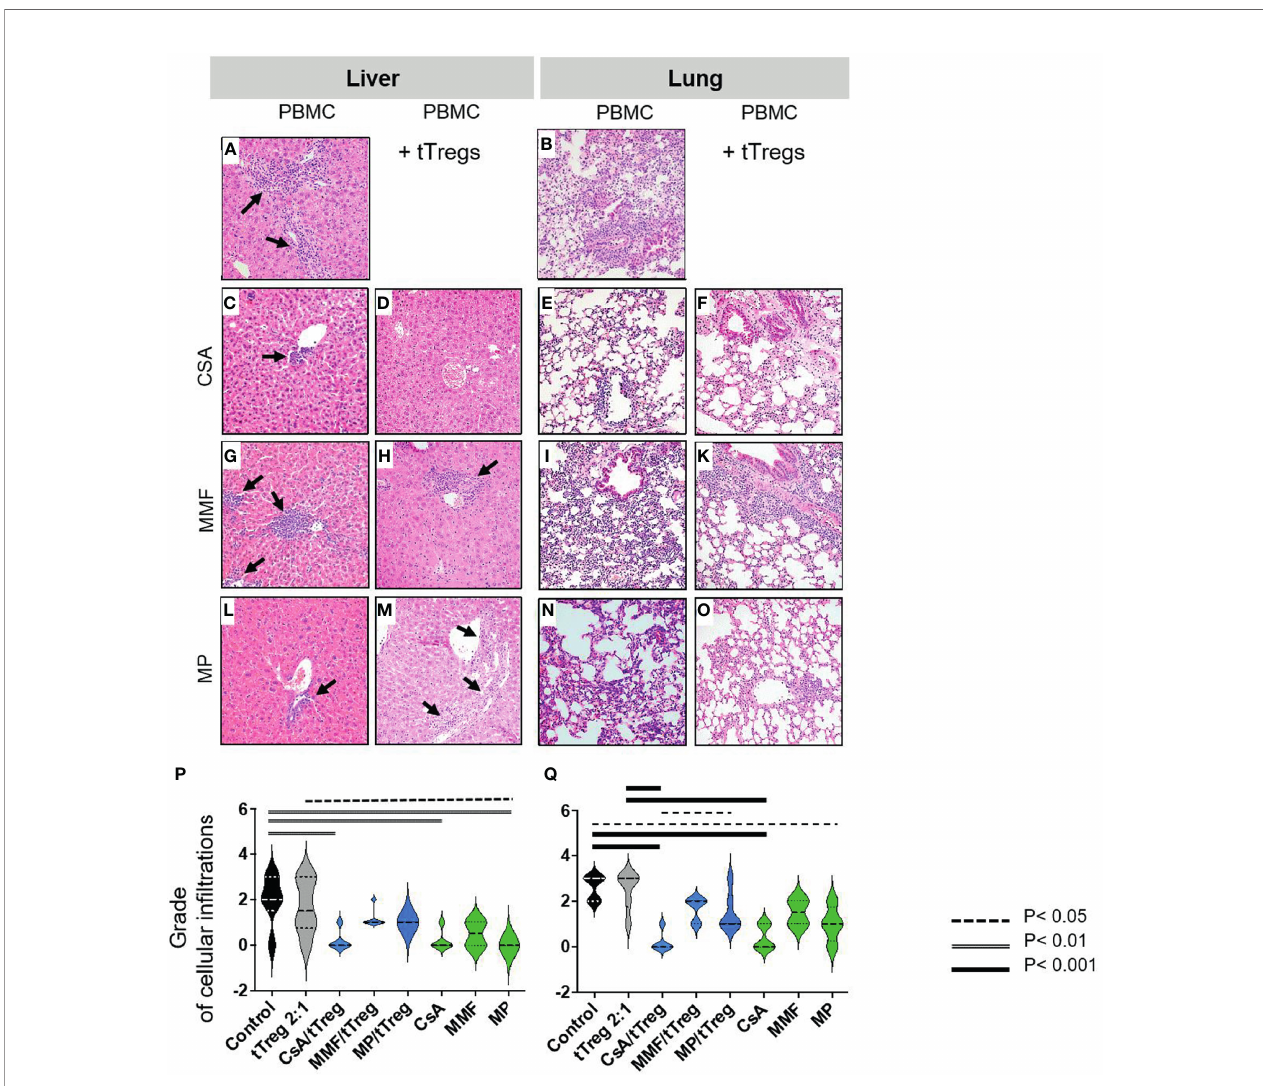
FIGURE 3 | Histopathologic changes of liver and lung. Liver and lungs of mice described in Figure 1 were stained with Hematoxylin/Eosin (HE). Depicted are (A – O) representative images from liver and lung samples at 20-fold magni fi cation and (A, B) moderate to high-grade cellular in fi ltration and in fl ammation in liver and lungs of animals that received PBMCs but no GvHD therapy. (A) Liver shows signi fi cant bile duct damage, grade 3 lobular in fl ammation with dense lymphocyte in fi ltration and lymphocyte ballooning (arrows). (B) Lung tissue shows massive intra-alveolar and intraepithelial lymphocyte in fi ltration with in fl ammation of the pulmonary epithelium and apoptotic bodies as well as loss of alveolar tissue architecture. (C – F) Only mild lymphocyte in fi ltration and almost complete resolution of in fl ammation with preserved tissue architecture in both liver (C, D) and lung (E, F) were observed in mice treated with CSA (C, E) or CSA + Tregs (D, F) . (G, H) Signi fi cant reduction of hepatic lymphocyte in fi ltration and in fl ammation after MMF monotherapy; moderate in fi ltration of lymphocytes and signs of in fl ammation in mice which received combined MMF/tTreg therapy with preserved hepatic tissue architecture. (I – K) Only partial reduction of lymphocyte in fi ltration and in fl ammation in lung of mice which received MMF alone or in combination with tTregs. (I) Dense lymphocyte in fi ltration leading to diffuse alveolar damage and septal edema. (K) Alveolar architecture partially preserved after MMF/tTreg co-administration. (L – O) Signi fi cant reduction of cellular in fi ltration and preserved tissue architecture in both liver and lung upon treatment by MP alone or in combination with tTregs. (P, Q) shows quanti fi cation of lymphocyte in fi ltration of liver (P) and lung (Q) . Statistical analysis was performed as One-Way-ANOVA with Tukey correction for multiple comparisons. Statistical signi fi cance levels are indicated as p < 0.05 (dotted line), p < 0.01 (dashed line), p < 0.001 (bold line), p < 0.0001 (solid line with asterix). CSA, Cyclosporine A; MMF, Mycophenolate Mofetil; MP,